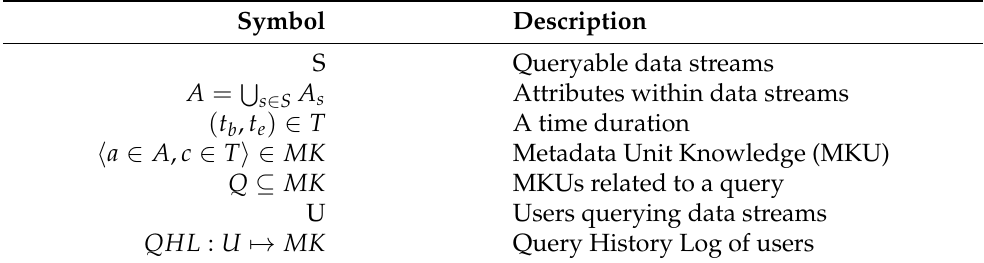
Table 1. Symbols defined to model user knowledge in